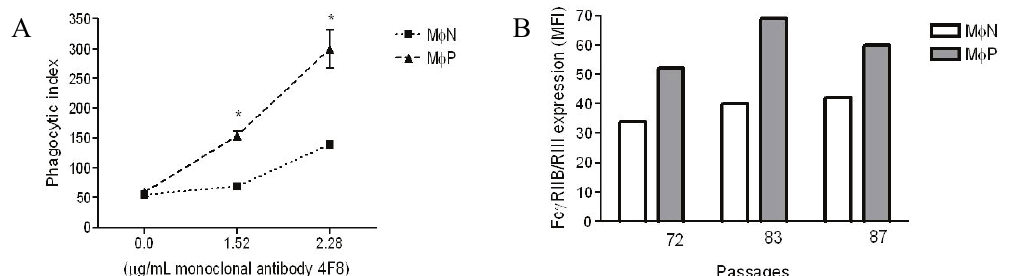
Figure 2. Fc γ RIIB/RIII mediated phagocytic activity and expression of Fc γ RIIB/RIII receptors in M φ P and M φ N. ( A ) Phagocytosis of IgG-opsonized and non-opsonized SRBC by M φ N and M φ P. Cells were incubated with 2,4,6-trinitrophenyl-labeled SRBC opsonized with the indicated concentrations of the anti-2,4-dinitrophenol (anti-DNP) IgG antibody 4F8. Results are expressed as mean ± 1 SD from three independent experiments passages of M φ N and passages 72, 83 and 87 of M φ P (* p < 0.05); ( B ) Expression of Fc γ RIIB/RIII in the above mentioned passages of M φ N or M φ P cells. Cell-membrane Fc γ RIIB/RIII were stained with specific monoclonal antibody 2.4G2 and secondary FITC-labeled F(ab') fragments of anti-rat antibodies, and analyzed by flow cytometry. Each individual bar represents the MFI of 10,000 cells. Statistical analysis of the average of the three different passages of M φ N and M φ P (38.67 ± 2.4 vs . 60.33 ± 4.9, respectively) indicates a significant difference in Fc γ RIIB/RIII expression ( p =